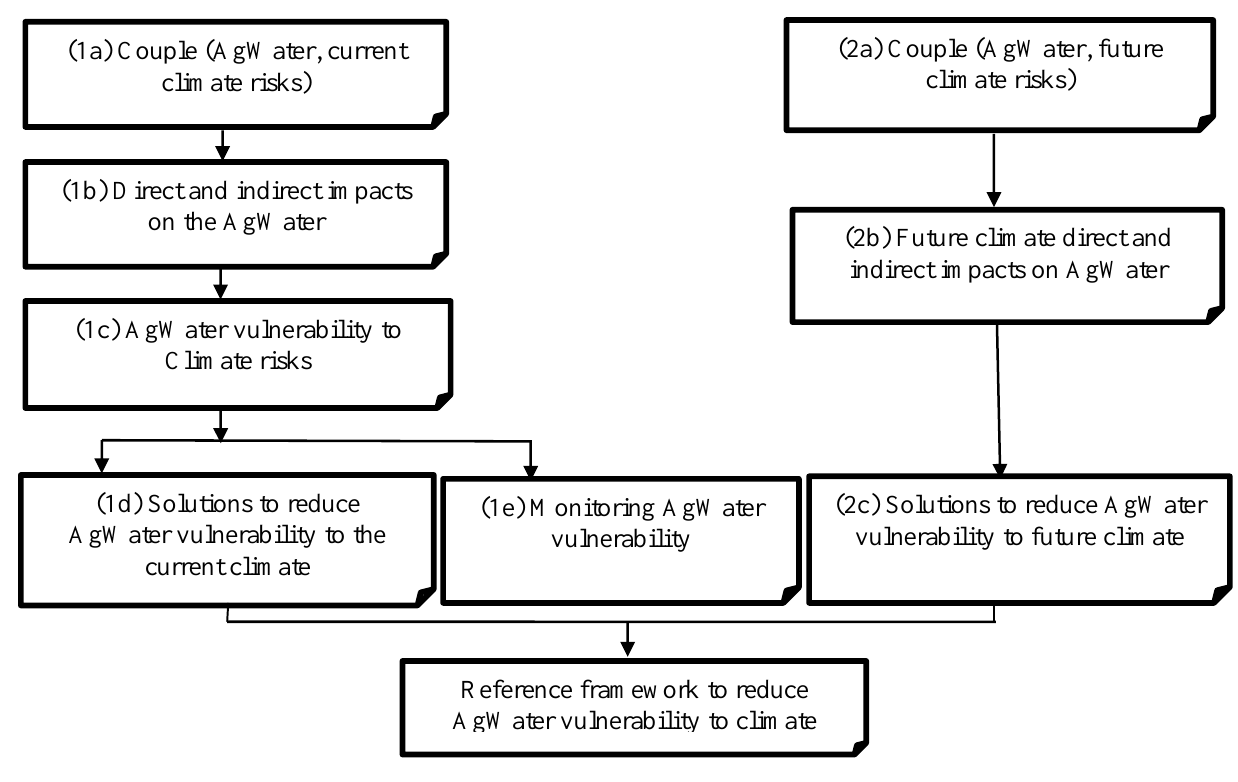
Figure 1. The ClimProspect model conceptual framework applied to agricultural water